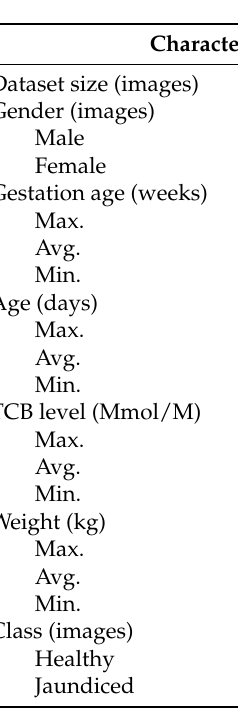
Table 2. Dataset characteristics.